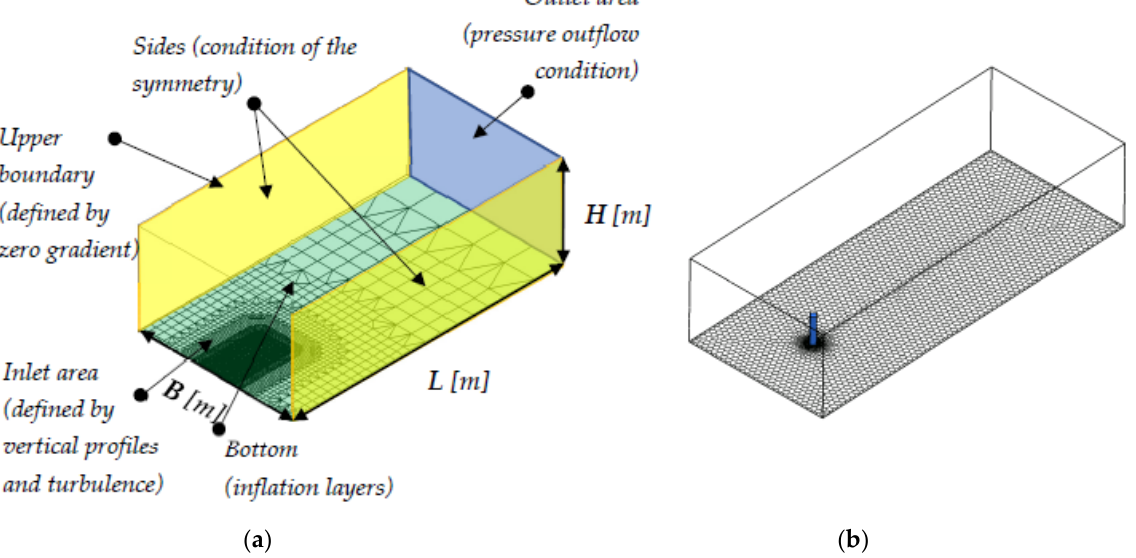
Figure 7. ( a ) Computational domain and boundary conditions; ( b ) stand-alone building in the computational domain.